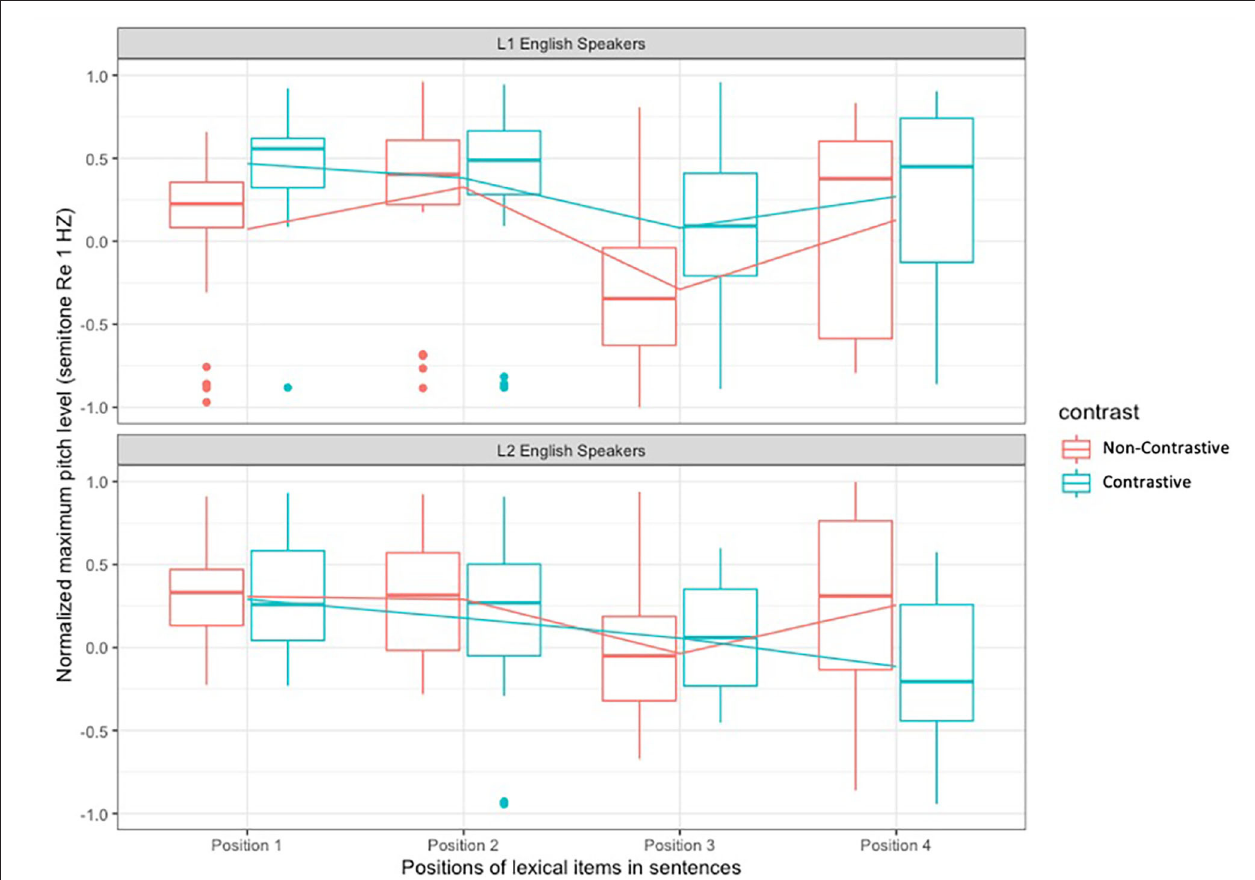
sentences were recorded. The research questions we asked in experiment 2